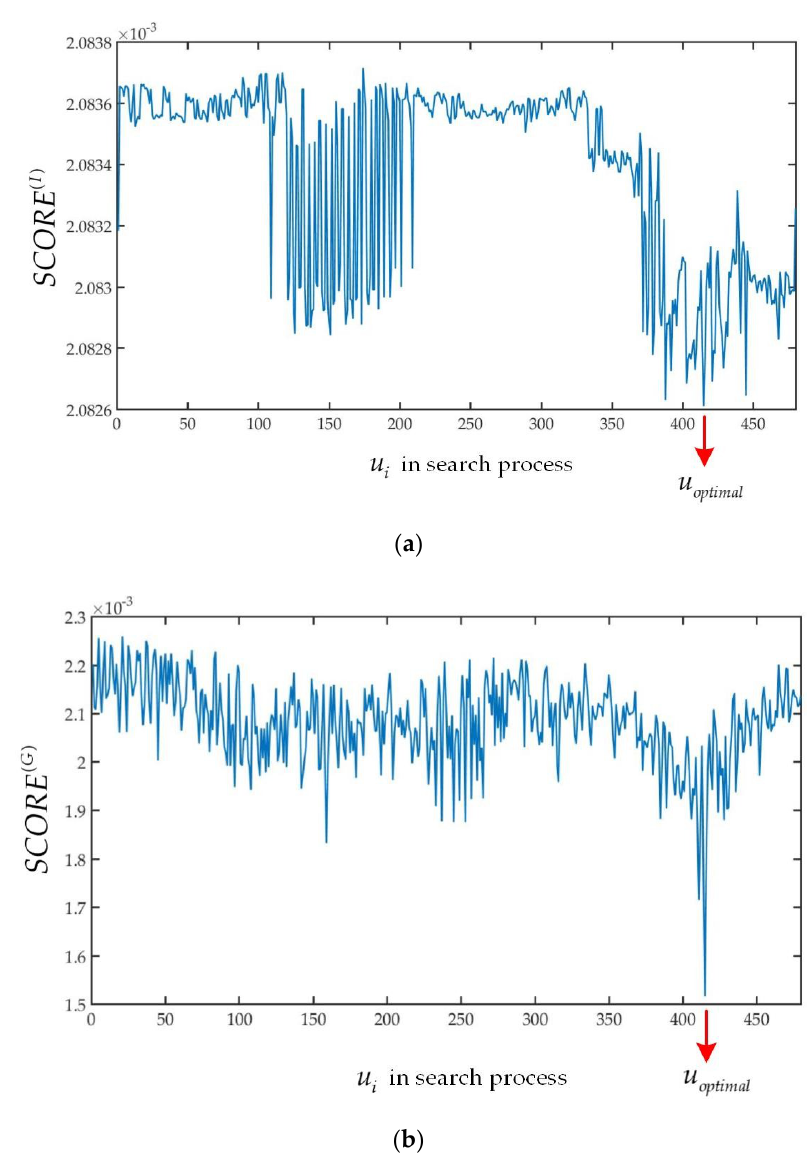
Figure 5. ( a ) The SCORE ( I ) curve will reach the minimum when optimal initial transformation guess is used. ( b ) The SCORE ( G ) curve will reach the minimum when optimal initial transformation guess is used.